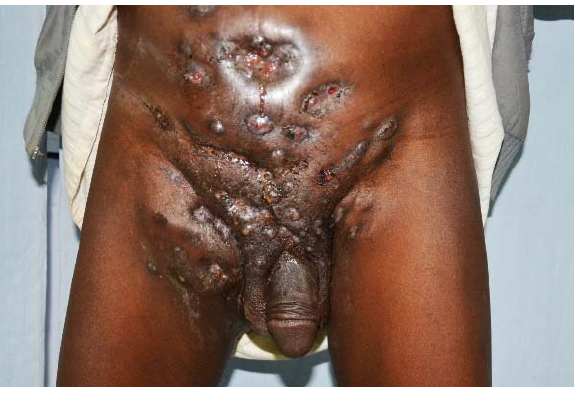
Figure 13. Massive anterior abdominal eumycetoma spreading to both inguinal regions and scrotum.